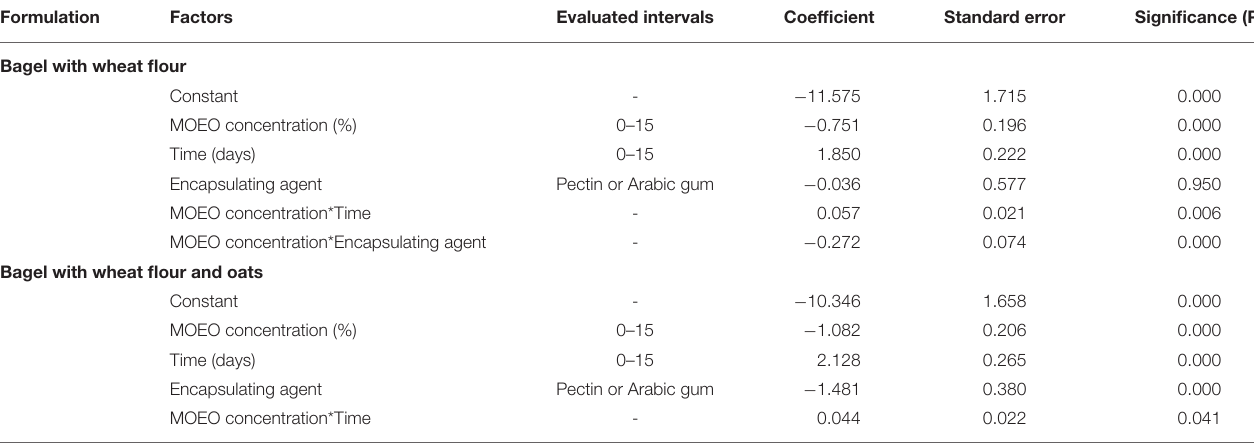
TABLE 7 | Parameters of the binary logistic regression model obtained for two formulations of bagels. Formulation Factors Evaluated intervals Coefficient Standard error Significance